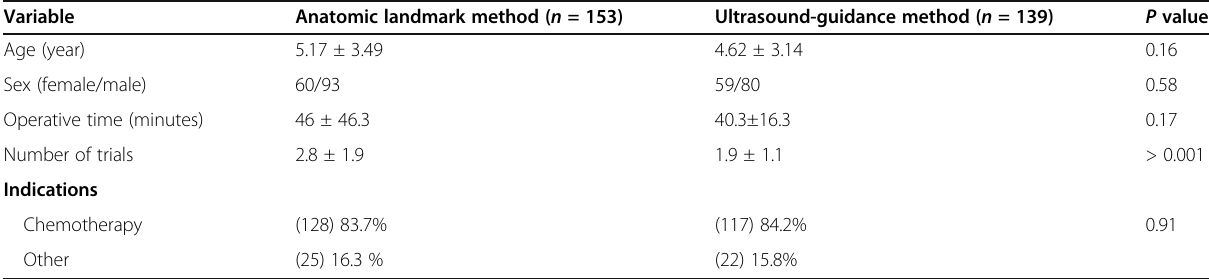
Table 2 Preoperative and operative data for patients who had central line insertion with the landmark versus ultrasound-guided method